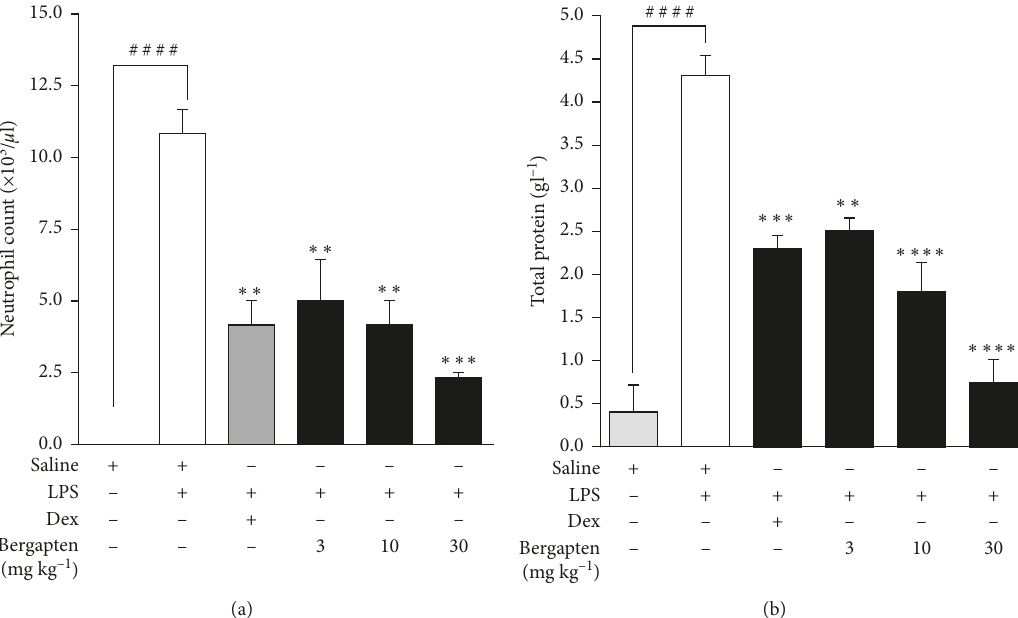
Figure 3: Effect of bergapten on neutrophil extravasation and total protein in BALF in LPS-induced lung inflammation. C57BL/6 mice were treated with either saline 10mlkg − 1 , dexamethasone 10mgkg − 1 , or bergapten 3–30mgkg − 1 for 1h. Test mice were challenged with LPS and sacrificed 24h later. BAL fluid was collected for neutrophil cell count (a) or centrifuged and supernatant used for total protein determination (b). Data are presented as cell mean count (10 3 / µ l) ± S.E.M ( n � 5). ∗∗ p < 0 . 01, ∗∗∗ p < 0 . 001, and ∗∗∗∗ p < 0 . 0001 compared to the saline-treated LPS-challenged disease control. #### p < 0 . 0001 compared to the naive control (one-way ANOVA followed by Dunnett’s post hoc